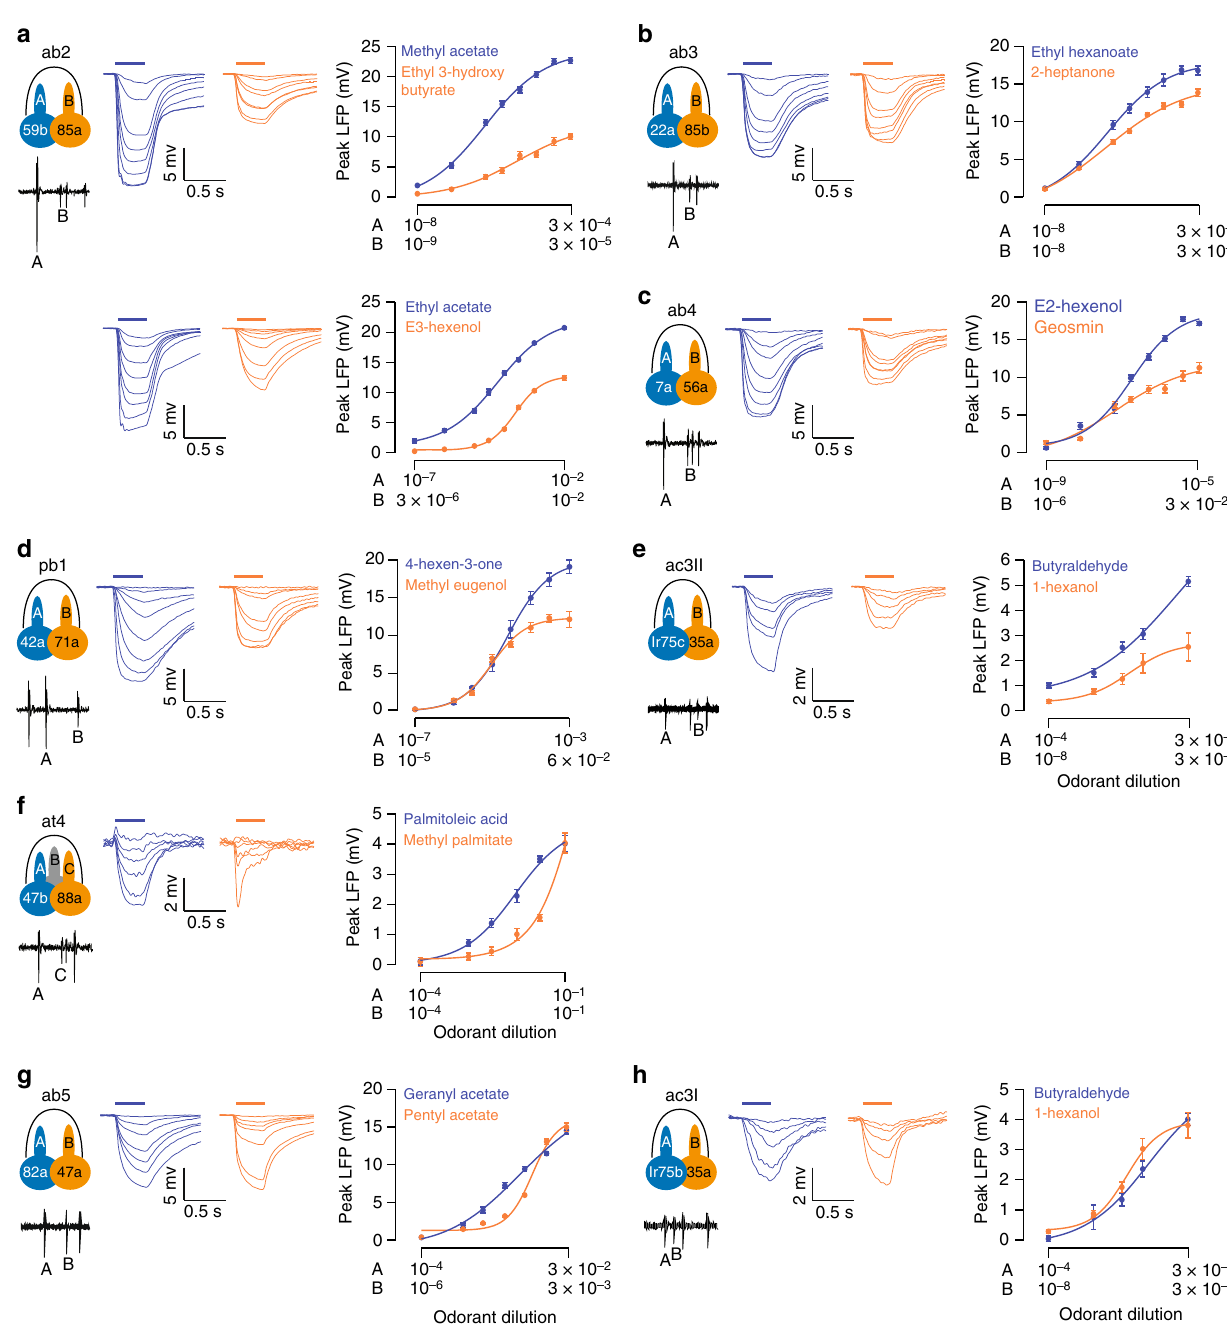
Fig. 2 Comparison of the fi eld responses of grouped neurons. a – f Dose − response relationships of grouped ORNs that have distinct extracellular spike amplitudes. a Left: Spontaneous activity of ab2A (large spike) and ab2B (small spike). Middle: Average local fi eld potential (LFP) responses of ab2A (blue traces) and ab2B (orange traces). Paired ORNs in the same sensilla were recorded in response to their respective private odorants at increasing concentrations. Right: Dose − response relationships of ab2A (blue) and ab2B neurons (orange) to methyl acetate and ethyl 3-hydroxy butyrate (top) or ethyl acetate and E3-hexenol, respectively (bottom). The absolute values of the peak LFP responses are shown. The highest and lowest concentrations of the “ A ” and “ B ” odorants are indicated logarithmically on the x -axis and aligned arbitrarily to facilitate comparison. b – f Additional sensillum types (ab3, ab4, pb1, ac3II and at4) were examined in a similar manner, as shown in a . g , h Average LFP responses and dose − response curves of grouped ORNs that exhibit similar extracellular spike amplitudes ( g ab5; h ac3I). n = 9 pairs of ORNs, except for ac3: n = 6 pairs, mean ± s.e.m. Fit is with the Hill equation. Source data are provided as a Source Data fi le. ORN olfactory receptor